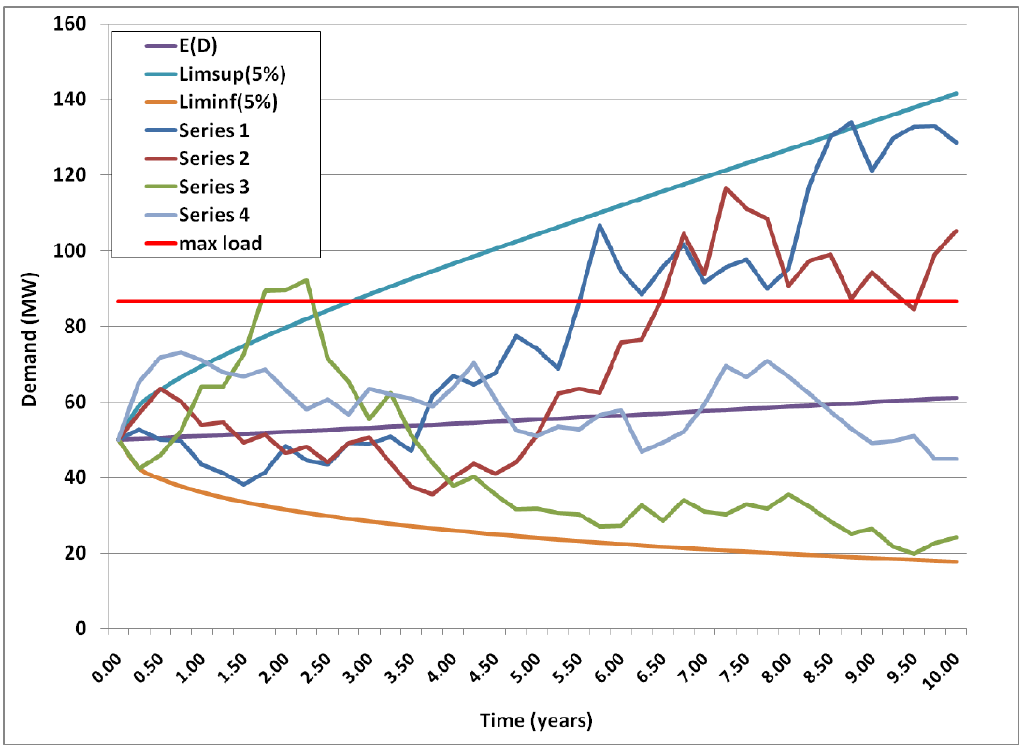
Figure 6. Stochastic demand and 95 per cent confidence